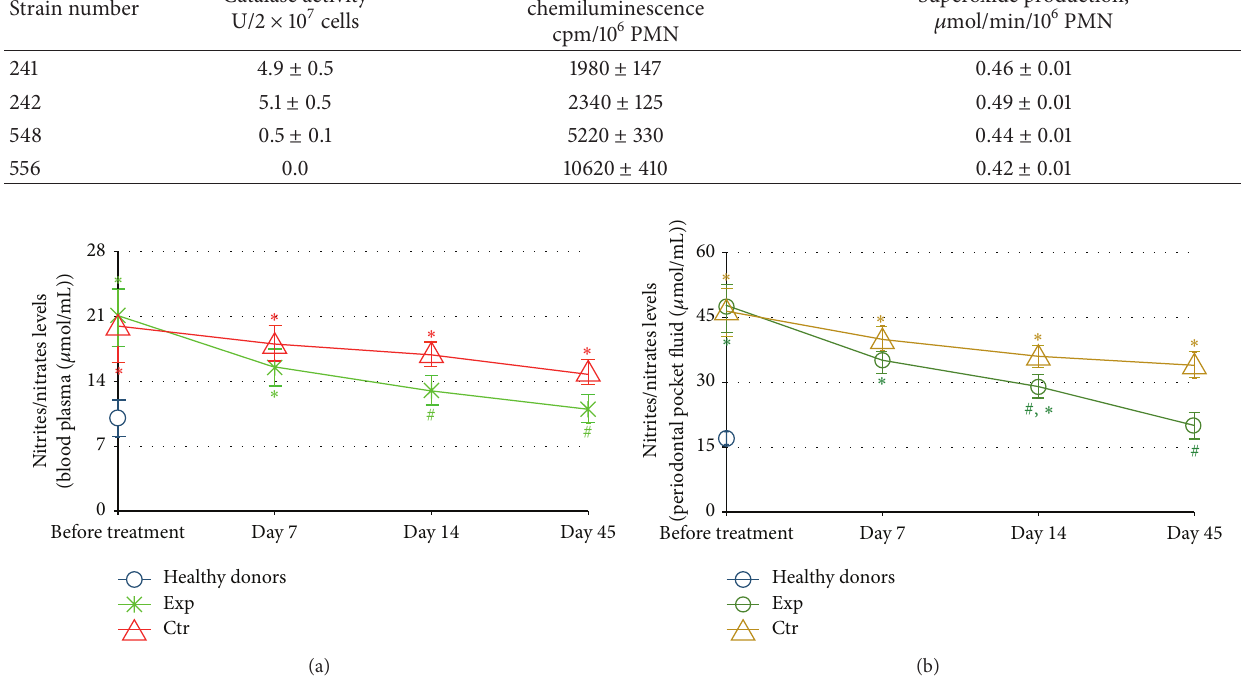
Figure 2: Dynamics of nitrite and nitrate levels ( 𝜇 mol/mL) in plasma (a) and crevicular periodontal fluid (b). The experimental group (Exp, 𝑛 = 39 ) was treated with conventional periodontal treatment plus topical daily application of fermented papaya gel into gingival pockets; the control group (Ctr, 𝑛 = 45 ) received conventional periodontal treatment for the same period of time. Healthy donors: 𝑛 = 25 . Values are represented as mean and standard deviation (SD). # 𝑃 < 0.05 versus analogous day of treatment in the control group; ∗ 𝑃 < 0.05 versus healthy